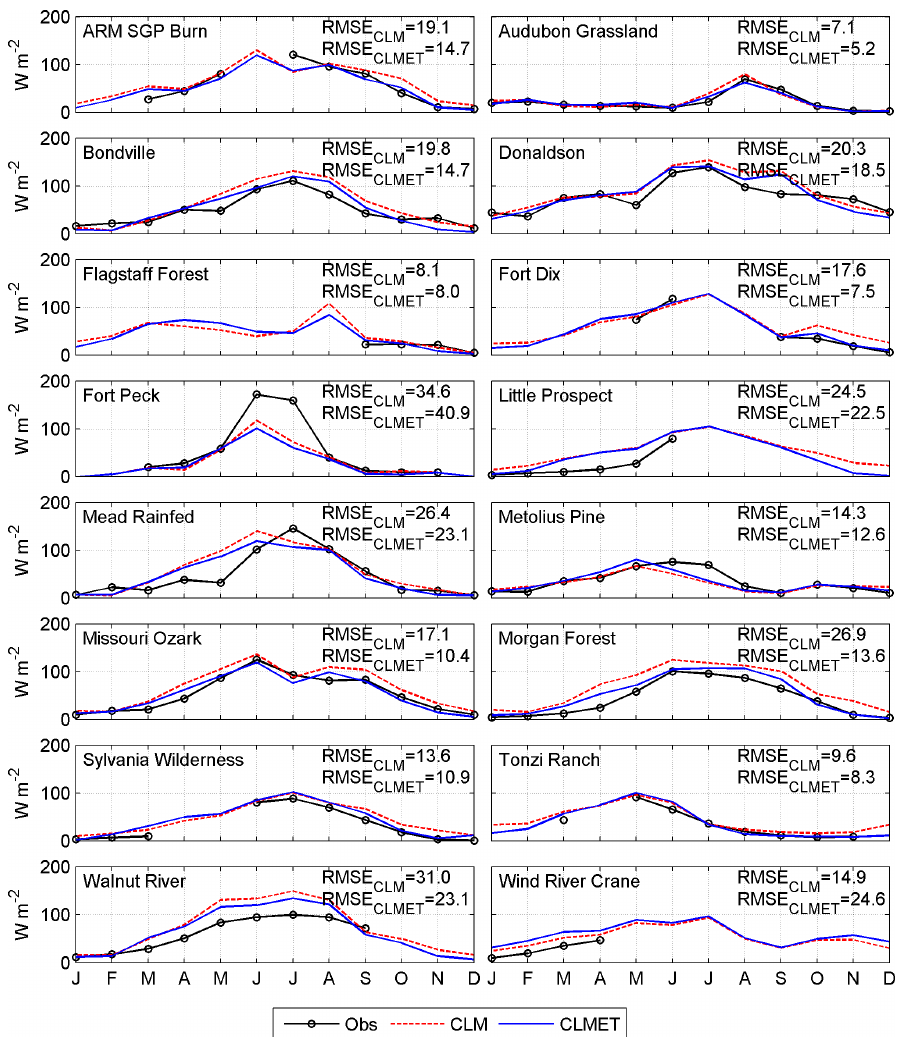
Figure 8. Monthly mean latent heat fluxes from the CLM and CLMET and observations at 16 flux tower sites. RMSE CLM and RMSE CLMET represent the root mean square error against observations for the CLM and CLMET, respectively. Note that the CLM and CLMET simulations are driven with meteorological forcings at the grid cell level (as opposed to site-specific